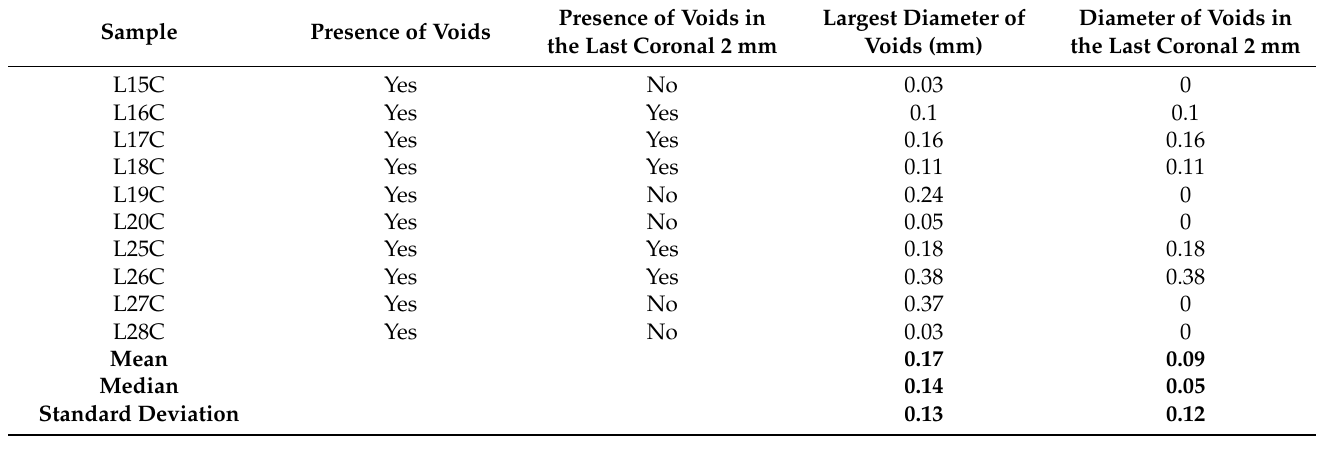
Table 8. Voids detected in the control group.